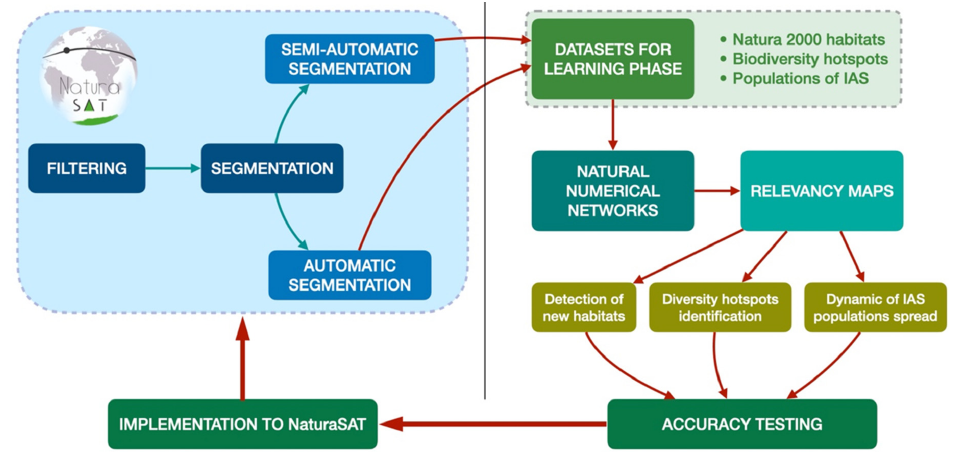
Figure 13. A scheme showing workflow of dynamic development and using of NaturaSat